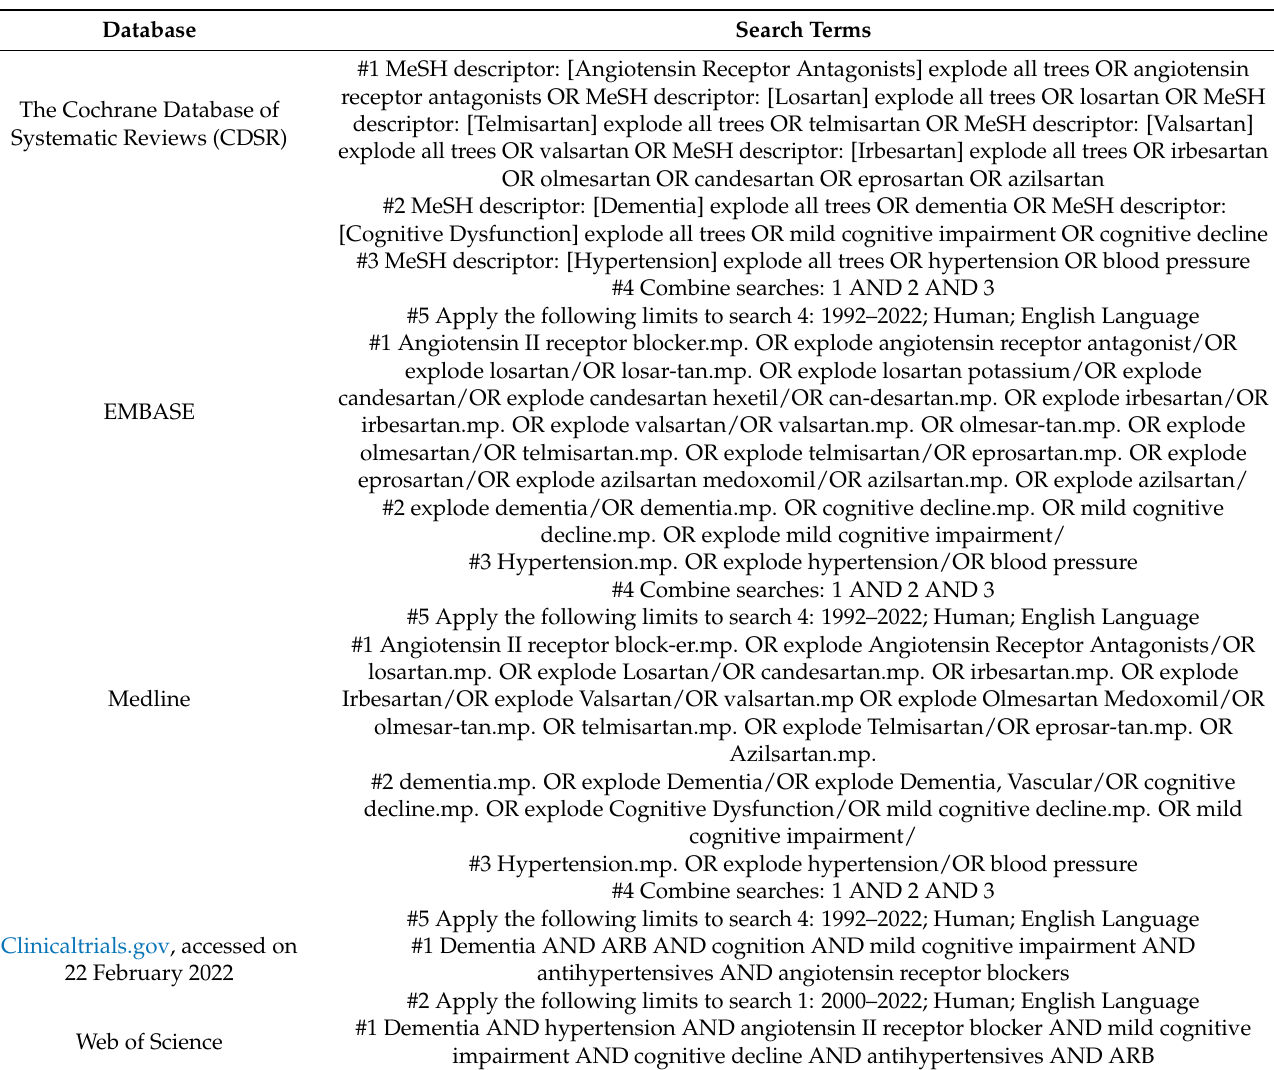
Table 2. Key mesh terms applied in CDSR, EMBASE, Medline, Clinicaltrials.gov, accessed on 22 February 2022, and Web of Science to search for appropriate